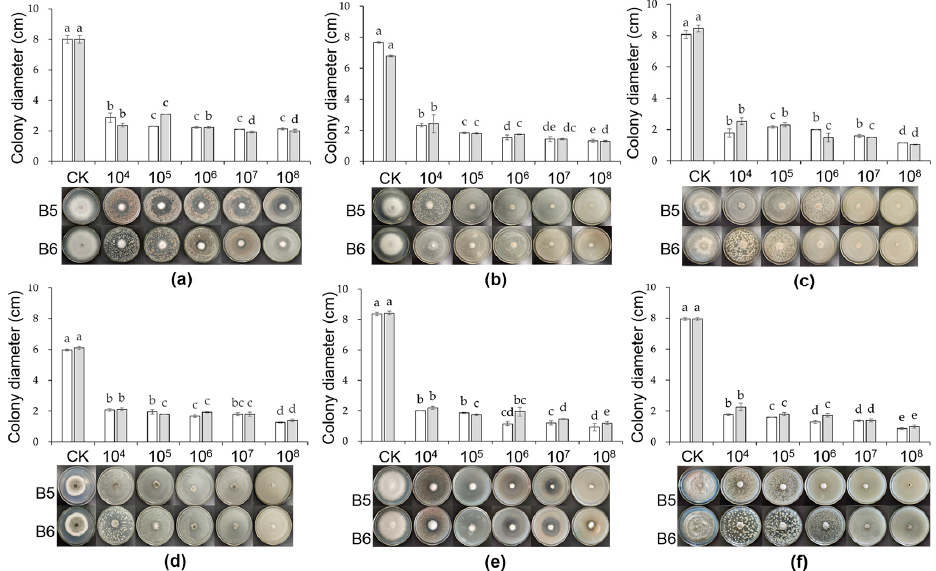
Figure 1. Inhibition effects of strain B5 (white rectangle) and B6 (grey rectangle) against F. oxysporum f. sp. conglutinans race 1 ( a ), F. oxysporum f. sp. conglutinans race 2 ( b ), Botrytis cinerea ( c ), Alternaria solani ( d ), F. oxysporum f. sp. zingiberi ( e ) and A. alternata ( f ). Values were means of three replicates. Error bars represented standard error of the mean. For each pathogen, different lowercases above the columns indicated statistical difference at p < 0.05.